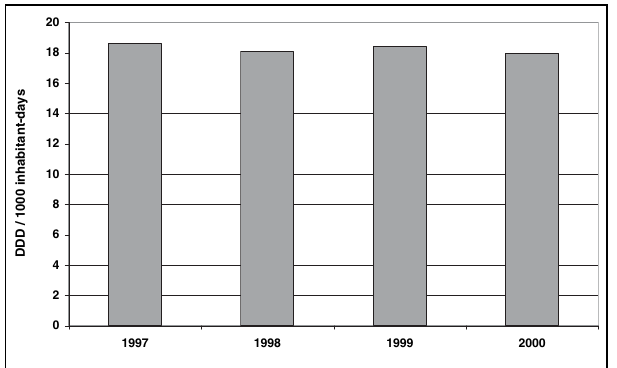
Figure 4) J01 Antibiotic consumption in ambulatory care patients in British Columbia (BC) and Denmark, 1997 to 2000. DDD Defined Daily Dose